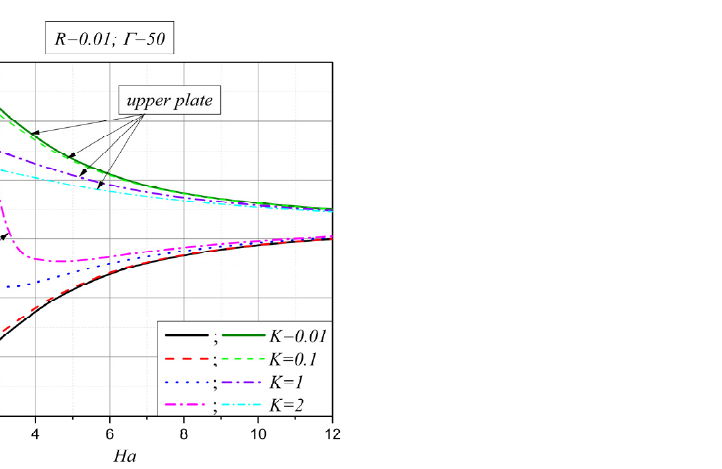
Figure 10. Dimensionless temperature 𝜃 as a function of Hartmann number.